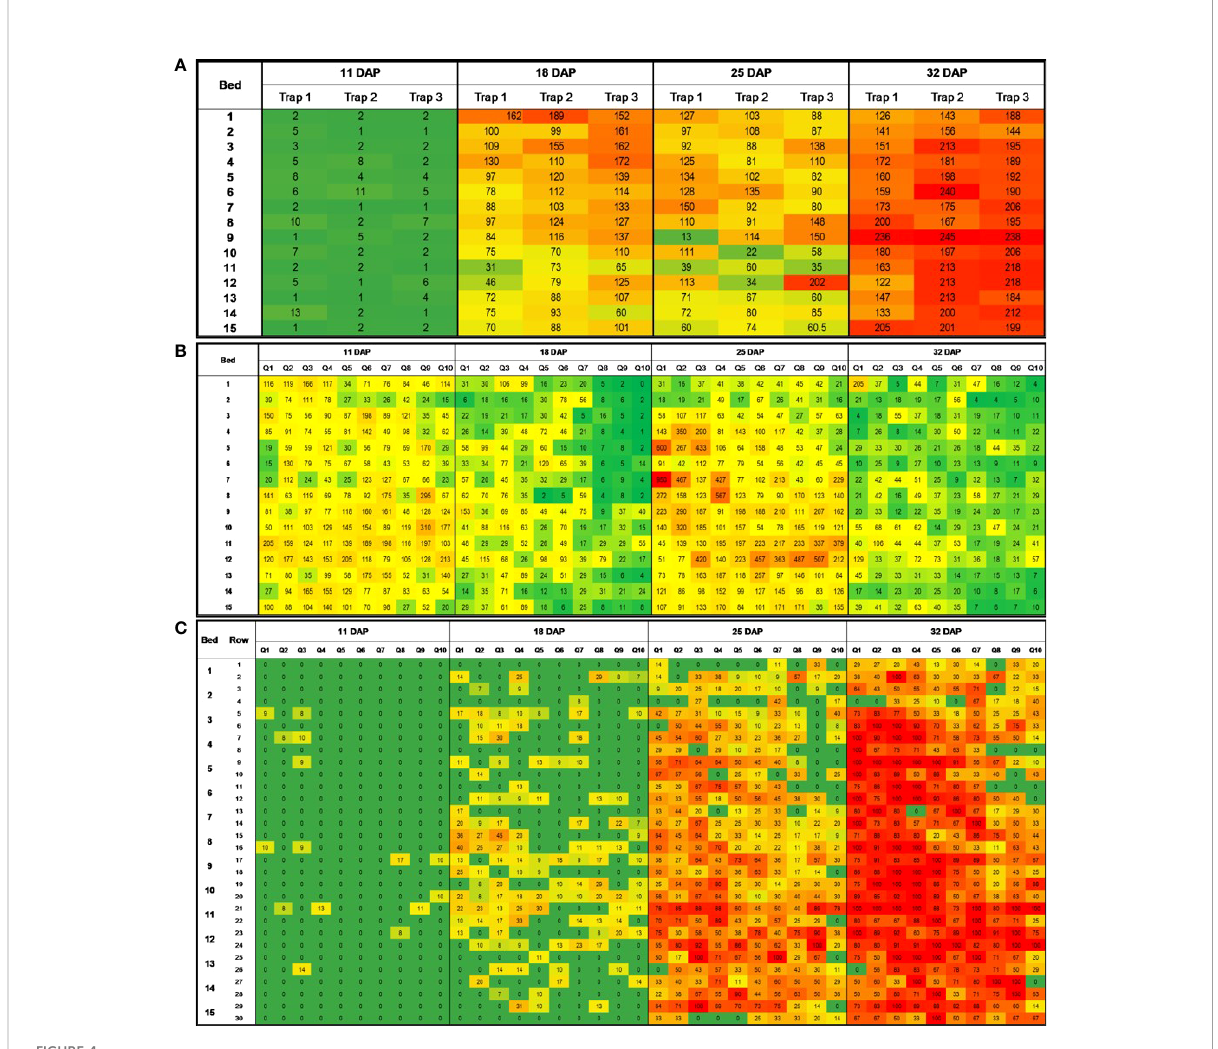
FIGURE 4 Heatmaps showing number of adult white fl ies a caught on sticky trap (A) , number of adult white fl ies in leaves (B) , and WTVC incidence b (C) over time and space in the experimental fi eld at the UGA Black Shank Farm in 2020. a Average number of adult white fl ies in eight 2cm 2 areas of a sticky trap (four in each side, front and back); b percent incidence of WTVC infected plants per 3.05m long rows of squash. Green areas had lower numbers of white fl ies and lower WTVC incidence. Red areas had higher white fl y counts and WTVC